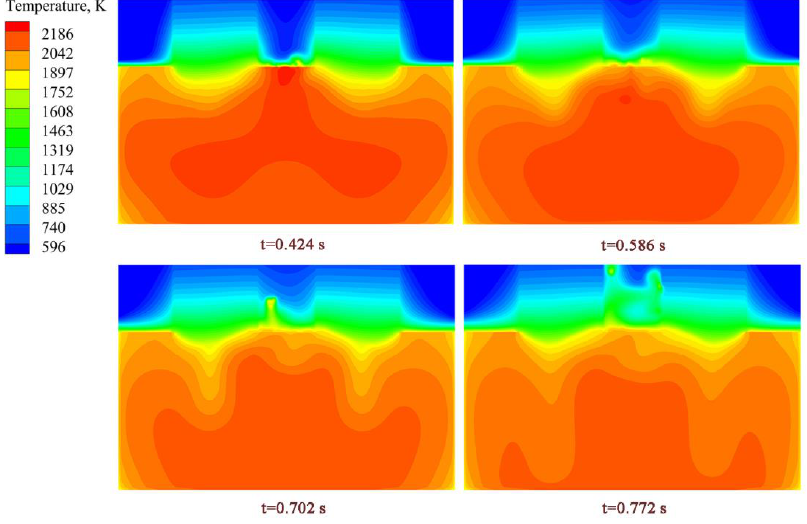
Figure 16. Distribution of the temperature field during the droplet dripping process of TSCE-ESR.